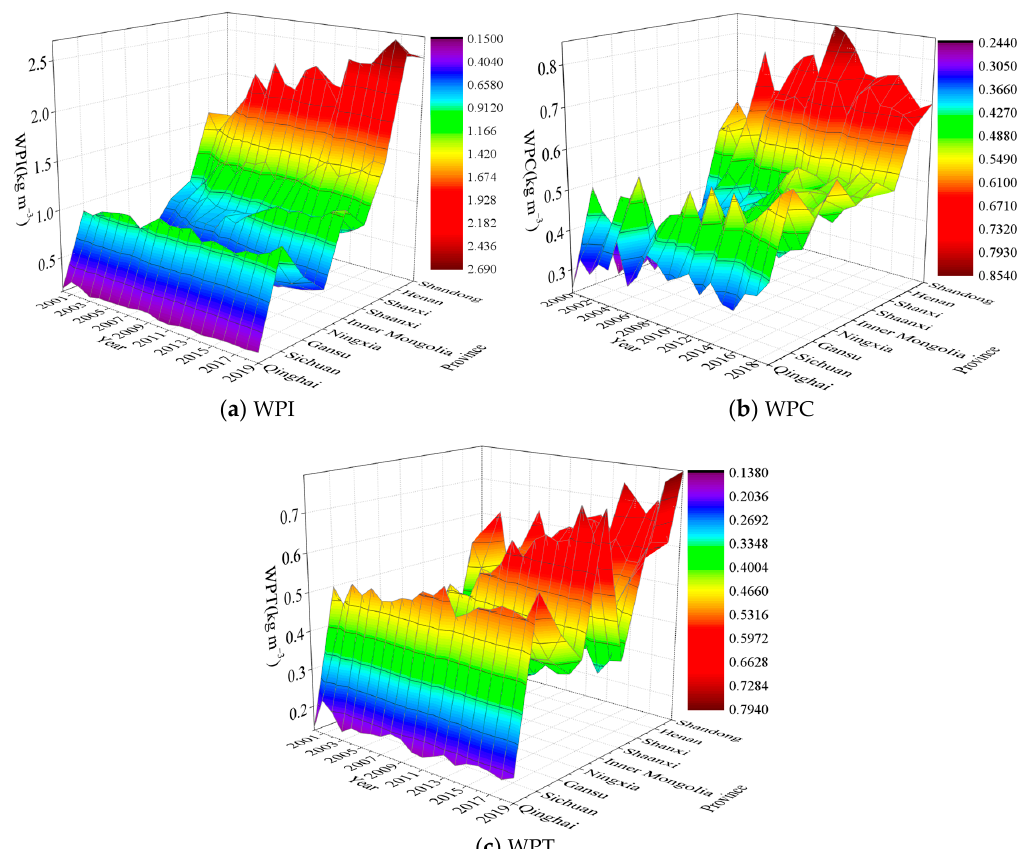
Figure 2. Temporal variation trend of water productivity in the Yellow River Basin: ( a ) the temporal variation trend of WPI, ( b ) the temporal variation trend of WPC, ( c ) the temporal variation trend of WPT. Table 3. The Global Moran’s I coefficient of water productivity in the Yellow River Basin from 2000 to